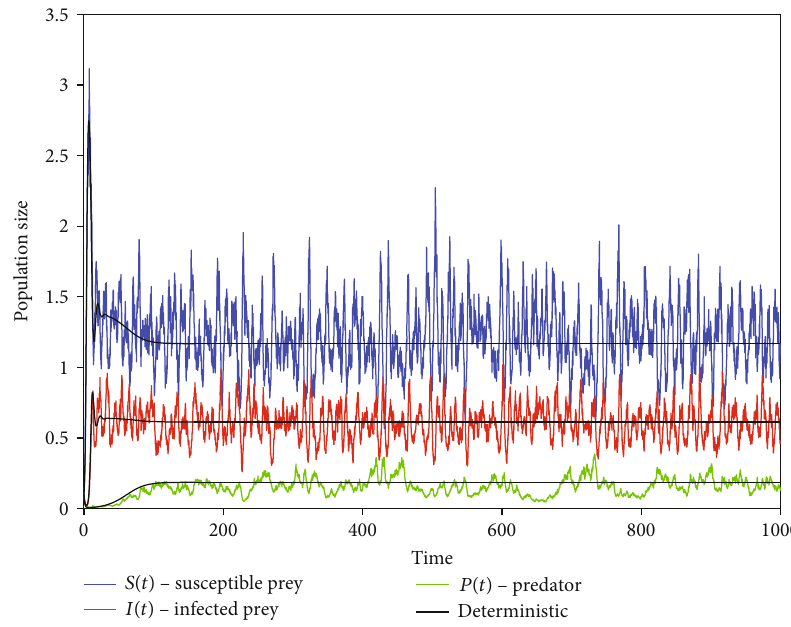
Figure 1: Simulation showing the solution curves of deterministic system (11) and corresponding stochastic system (23) with large noise σ = σ = σ = 0 : 1 1 2 3